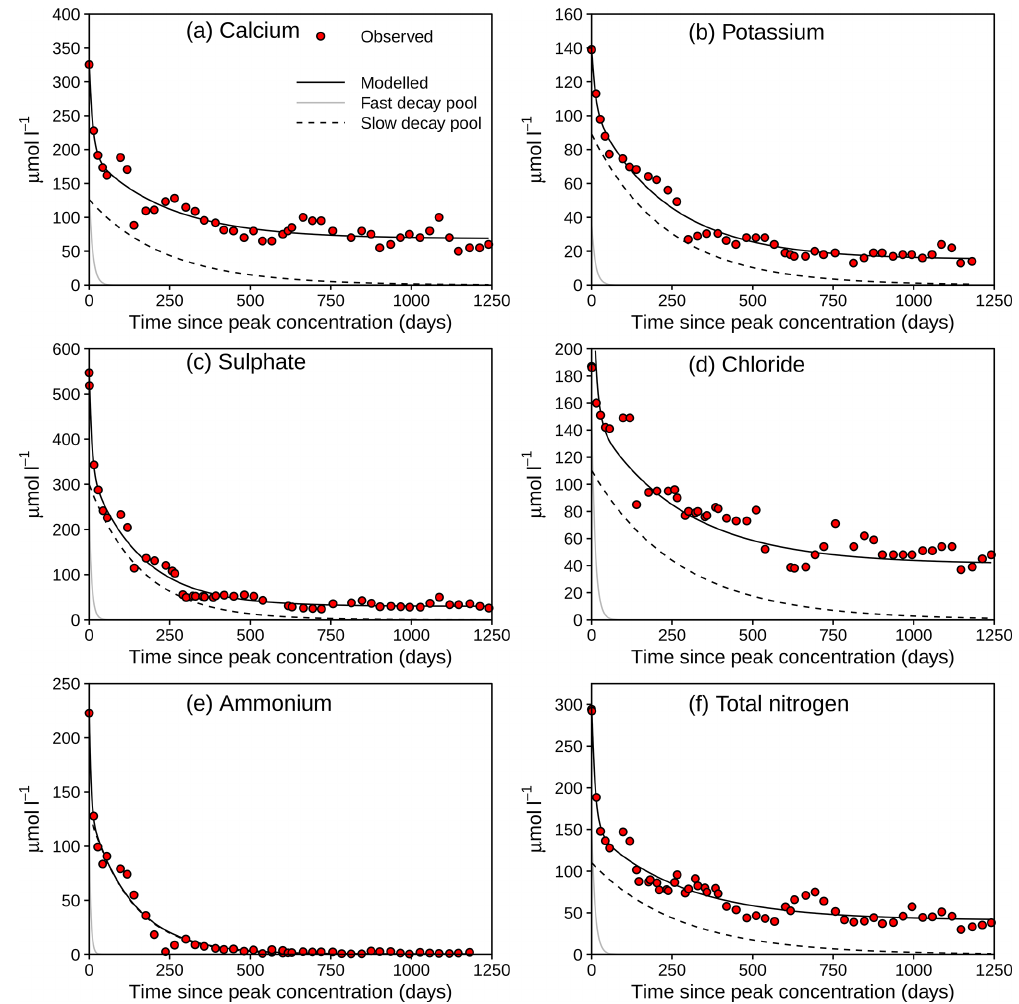
Figure 5. Fitted decay curves for solutes exhibiting a single concentration peak after the fire in Gärsjöbäcken. See Table 3 for statistics and model fits for the other